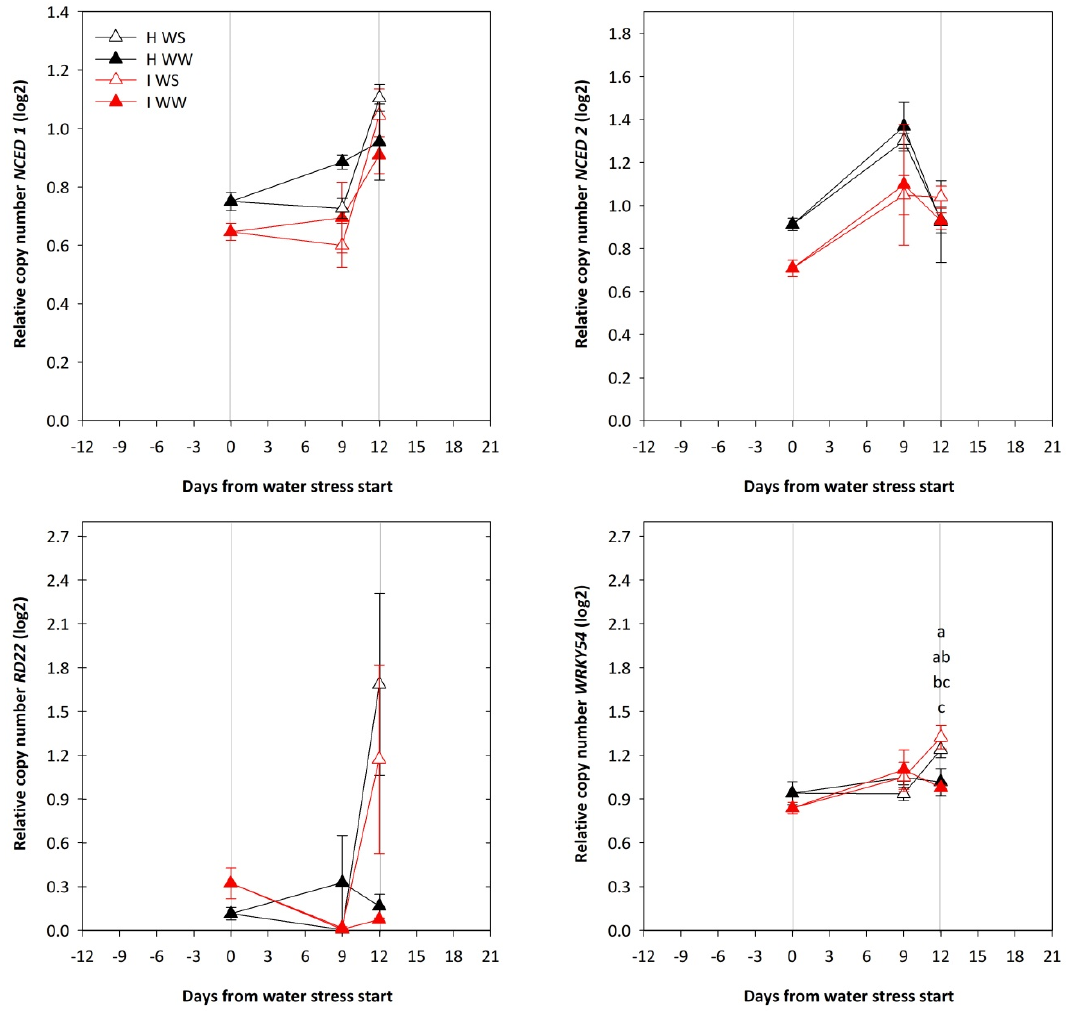
Figure 6. Expression of NCED1 , NCED2 , RD22 and WRKY54 genes in the young leaves of potted own-rooted grapevines of cv. Schioppettino before and during the water stress. Plants are separated regarding to plant health and water status: well-watered healthy (H WW), well-watered GFLV- infected (I WW), water-stressed healthy (H WS) and water-stressed GFLV-infected (I WS) plants. Error bars represent standard errors. For each time point separately, data were processed through ANOVA (significance reported in Supplementary Table S2), and means were separated with a Student Newman Keuls test ( p < 0.05; different letters represent significant differences between means). Grey lines represent the beginning and the end of water stress